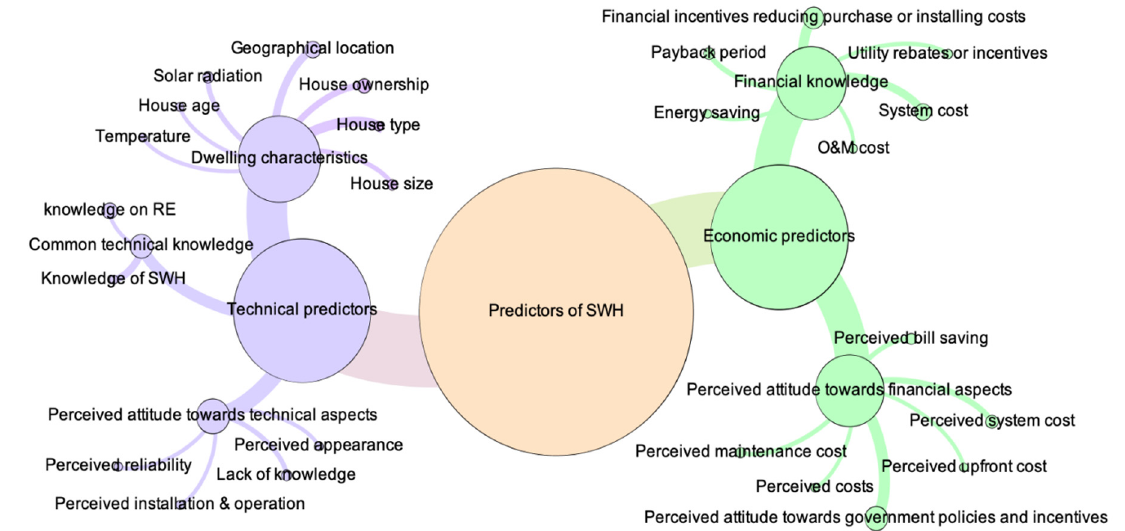
Figure 9. Comparison of the most frequently used predictors (>10 articles). Green colour = economic predictors, purple color = technical predictors, larger circles = more influential variables.